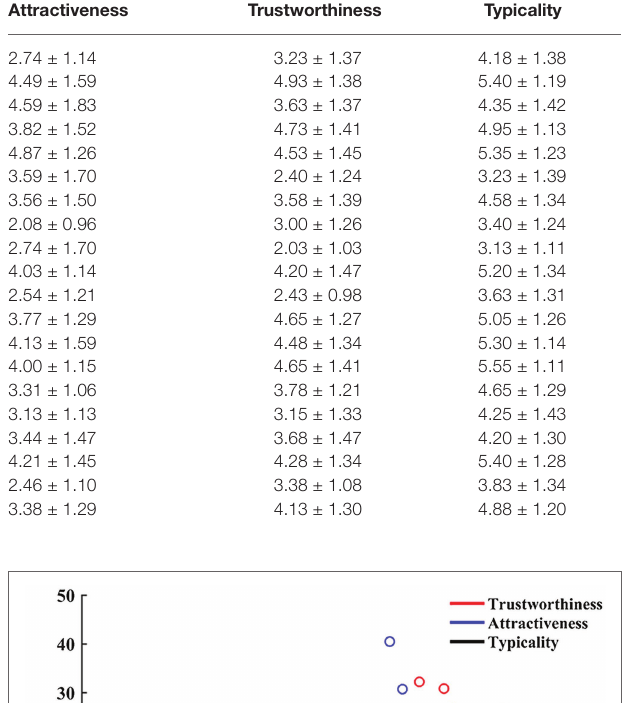
TABLE 5 | Slopes of fitted lines for the relationship between mean trait ratings of original faces and the predicted DFT for peaks of mean trait judgments in corresponding continua by gender of the participants ( M ± SD